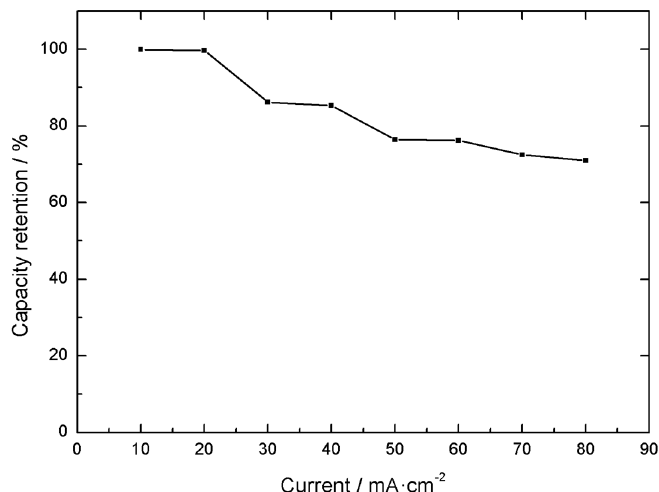
Figure 10. Capacity retention obtained for YEC-8A calculated at different applied current densities calculated from the third discharge curve in the − 1.0 V to 0.0 V vs. SCE voltage interval.